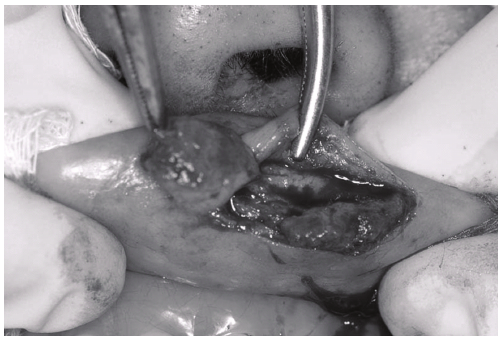
Figure 1: Capillaries (stars) invading muscle tissue (arrows; 200x, HE).